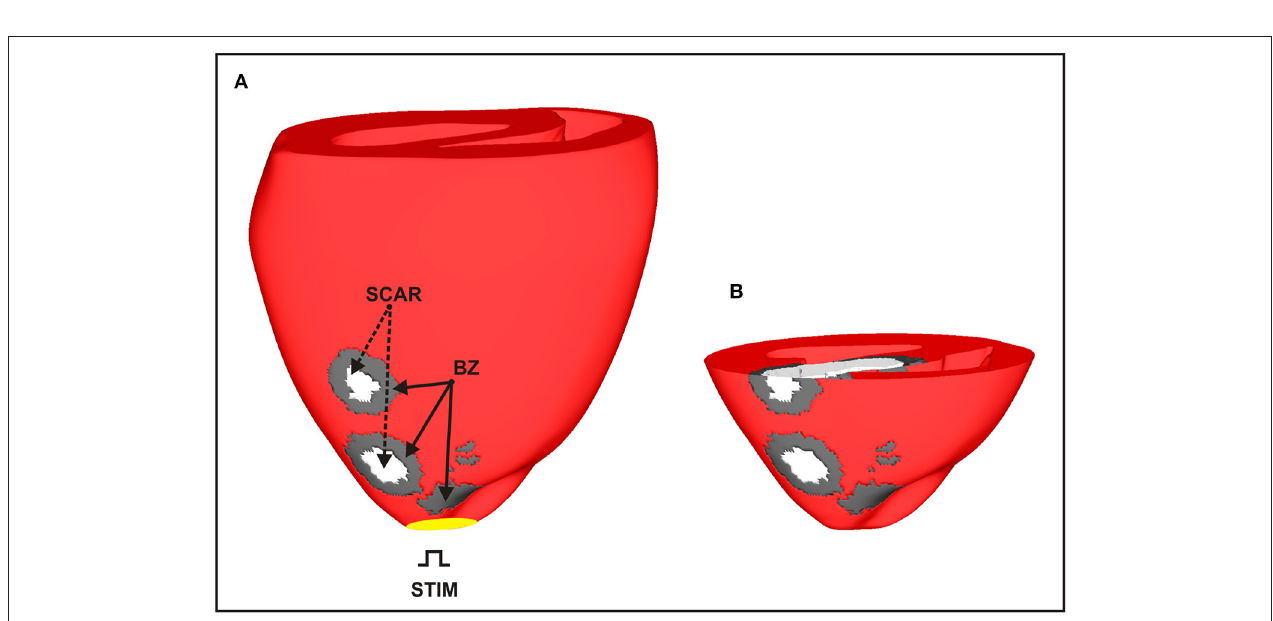
FIGURE 3 | Anatomically-based representation of infarct scar and BZ within the BiV model based on infarct formation following occlusion of the LAD. (A) Healthy ventricular tissue is shown in red with necrotic scar in white and BZ tissue in gray. (B) Short-axis clipping plane view highlighting intramural scar anatomy.